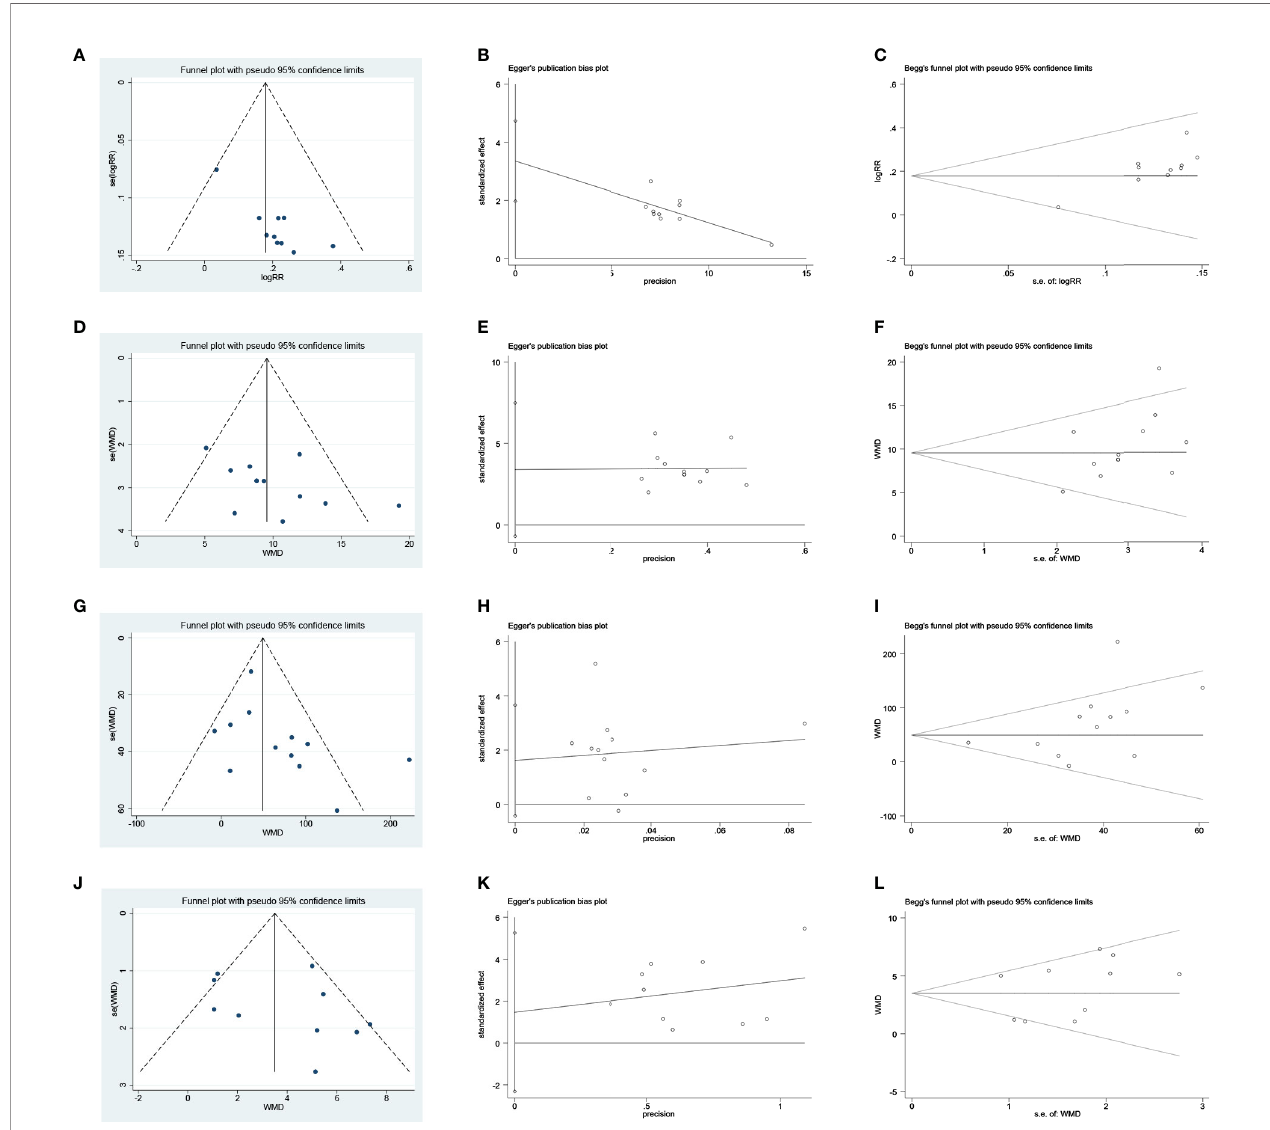
FIGURE 12 | Publication bias plots. (A) Funnel plot of clinical ef fi cacy rate; (B) Egger ’ s plot of clinical ef fi cacy rate; (C) Begg ’ s plot of clinical ef fi cacy rate; (D) Funnel plot of Hb; (E) Egger ’ s plot of Hb; (F) Begg ’ s plot of Hb; (G) Funnel plot of SCr; (H) Egger ’ s plot of SCr ; (I) Begg ’ s plot of SCr; (J) Funnel plot of BUN; (K) Egger ’ s plot of BUN; (L) Begg ’ s plot of